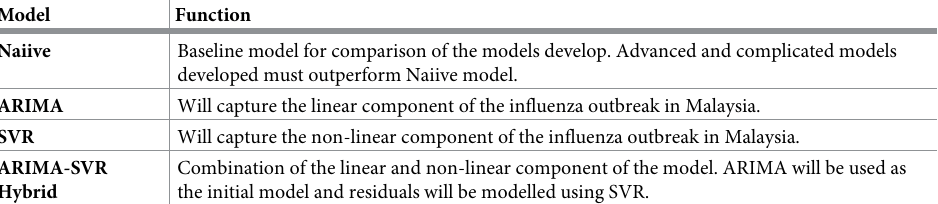
Table 1. Summary of the functions of the models used in this